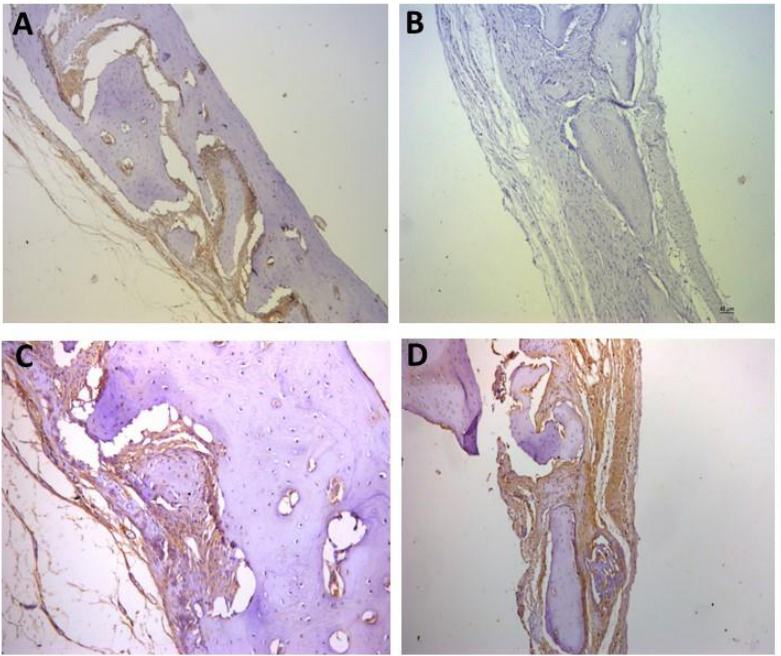
Figure 5. Representative immunohistochemistry images for IL1β staining. ( A ) control group; ( B ) negative control; ( C ) group 2 with marking considered (++); ( D ) group 7 with marking considered (++); the most observed staining pattern among the groups analyzed. Harris ’ hematoxylin counter- stained. Scale bar: 46 µm.